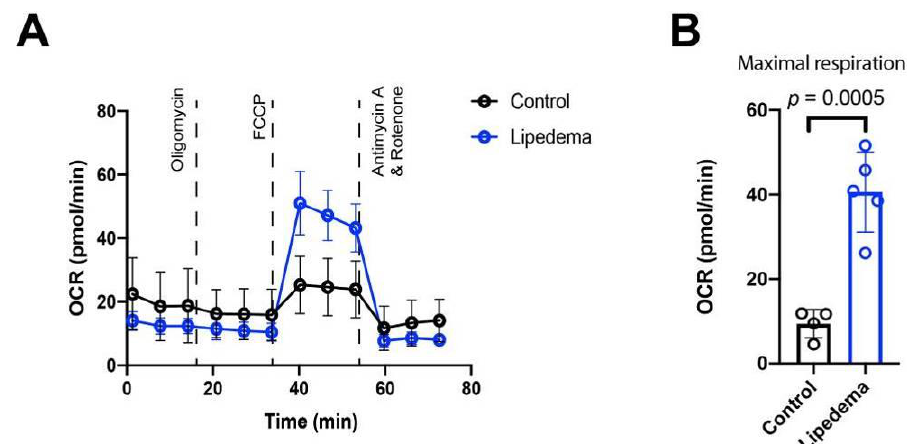
Figure 6. Oxygen consumption rates of stromal vascular fraction (0.15 × 10 6 cells/well) of lipedema and controls patients. ( A ) At the basal respiration, the ATP (adenosine triphosphate) linked respiration, the non-mitochondrial respiration, no significant alterations were observed. Each data point represents mean value of 4 or 5 patients. ( B ) Maximal respiration revealed a 4-fold increase in lipedema patient compared to controls. Maximal respiratory capacity is derived by subtracting the ORC (oxygen consumption rate) value at time point 6 from the value at time point 7. Each data point represents mean value of one patient. N (Control): 4 patients and N (Lipedema): 5 patients. The p -values indicate the statistical significance in comparison to the control (two-tailed Student t-test).